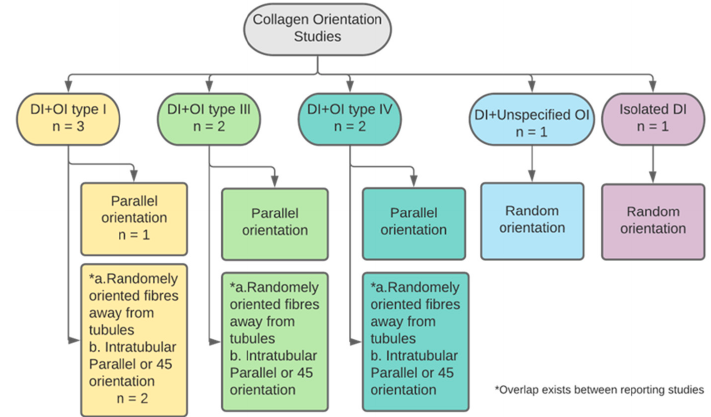
Figure 11. Categorisation of studies reporting on collagen orientation by DI and OI types.